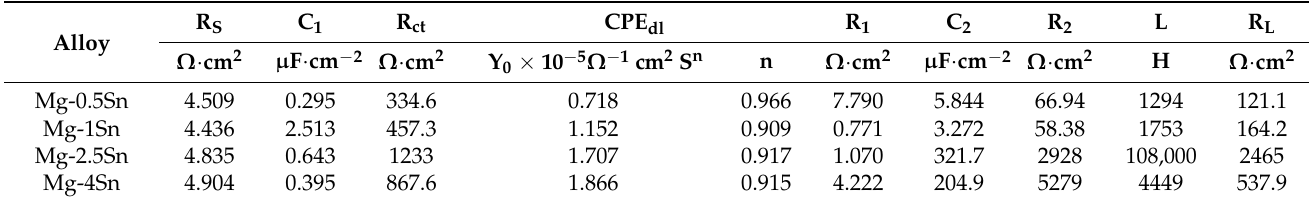
Table 3. Electrochemical parameters of the fitted equivalent circuits.